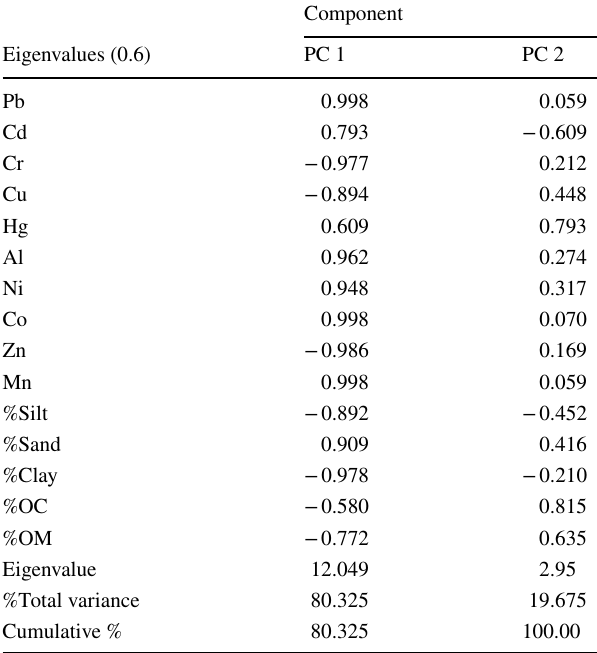
Table 8 Component matrix of two-factor model with strong to mod- erate loadings in